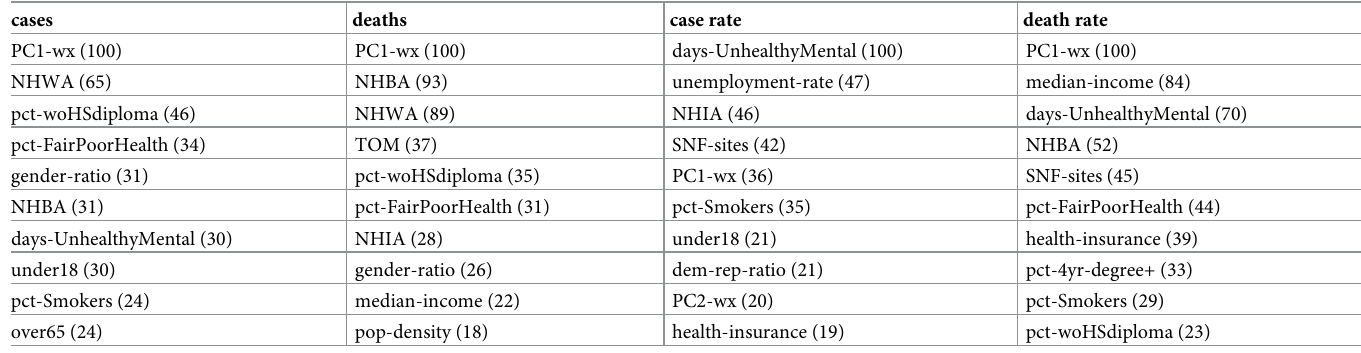
Table 4. Important variables by model.